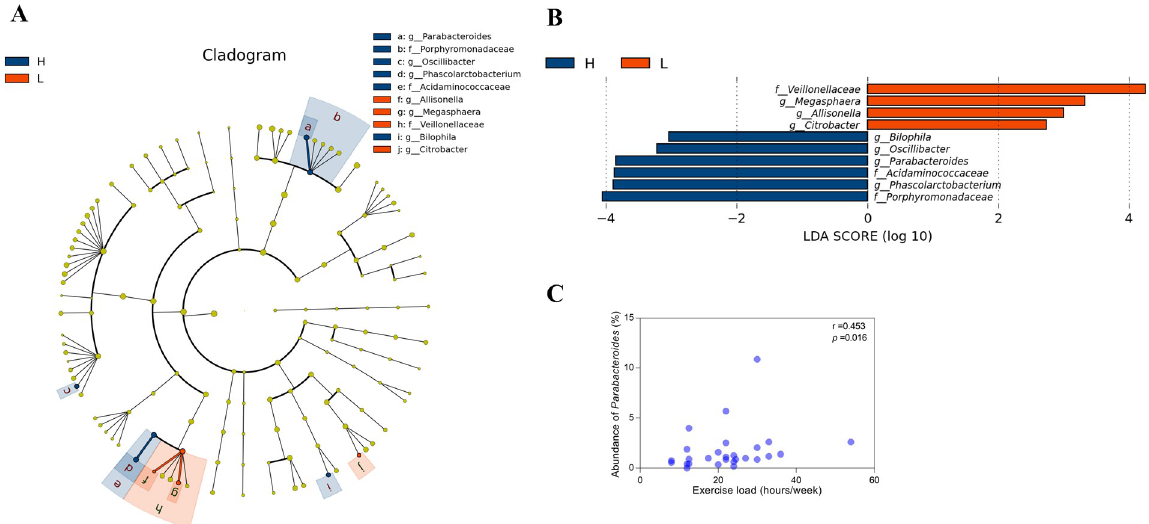
Fig 3. Taxonomic differences in the gut microbiota between the higher-level (H) and lower-level (L) groups. (A) In the cladogram, circles radiating from the inner side to the outer side represent the taxonomic level from family to genus. Blue nodes refer to the dominant bacteria in the higher-level athletes, and the red nodes refer to the bacteria dominant in the lower-level athletes; g, genus; f, family. (B) The histogram of the LDA scores represents the taxa whose abundance showed significant differences between the higher-level and lower-level athletes. The length of each bin, namely, the LDA score, represents the effect size. LDA, linear discriminant analysis; (C) The correlation between the exercise loads per week and the abundance of Parabacteroides in the athletes.